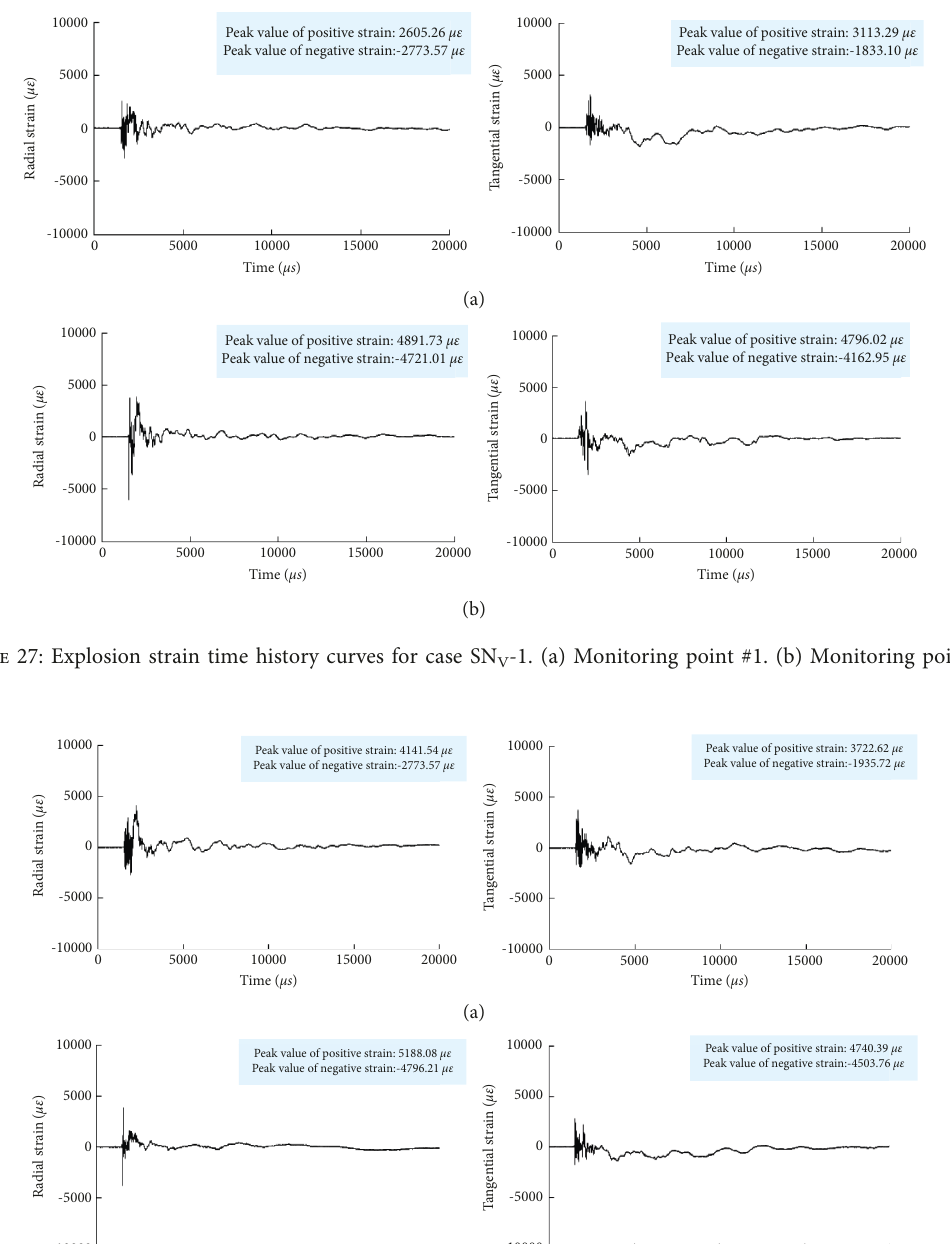
V -2. (a) Monitoring point #1. (b) Monitoring point